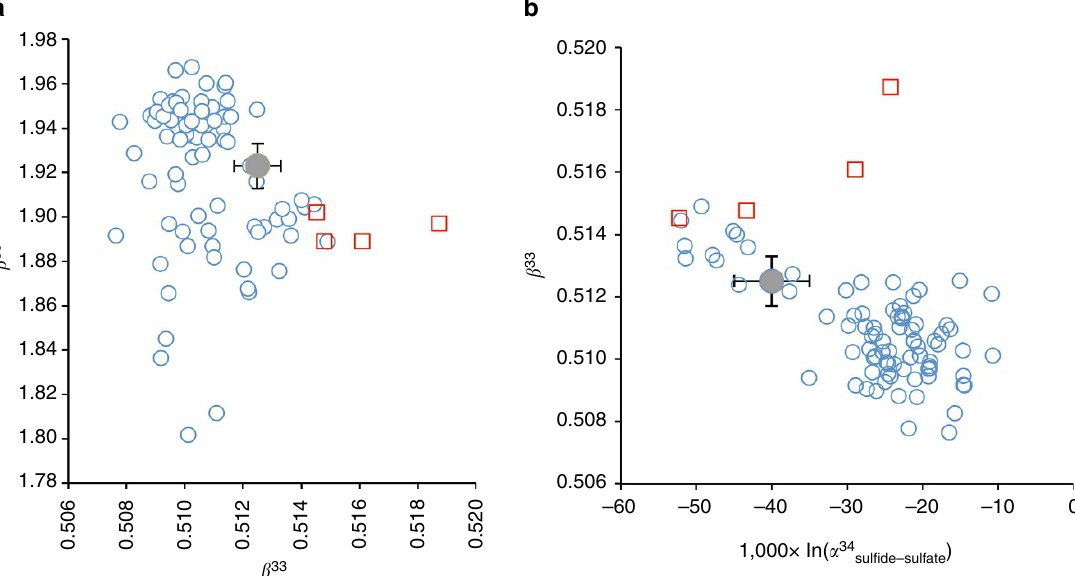
Figure 5 | Multiple isotope results of our study compared with batch culture results. ( a ) 33 b versus 36 b diagram. ( b ) 33 b versus 1,000ln( 34 a sulfide-sulfate ) diagram. Blue circles are data from BSR culture experiments, (refs 28,29,34–37). Red squares are data from SD culture experiments, ref. 29. The grey circle represents the results from our model (with the associated error bars, corresponding to the intersect between the solution space-Fig. 3a,b, and the field defined by culture experiments-Fig. (full grey circle). Although available data most clearly relate to BSR, one cannot rule out that part of the signal may reflect a mixed signature between SD and BSR organisms (Fig. 5). The final space of solutions in Fig. 3 is represented by a grey polygon which corresponds to the following combination of values: 34 a sulfide-sulfate B 0.960 ± 0.005, 33 b B 0.5125 ± 0.0005 and F in / F out ¼ 0.30 ± 0.25. The high sensitivity of the model allow to have precise values for the best-fit scenario, indeed slight modifications of each modelled parameter ( 34 a sulfide-sulfate , 33 b and F in / F out ) shows significant effects on the d 34 S CAS versus D 33 S CAS slope (Fig. 4b).